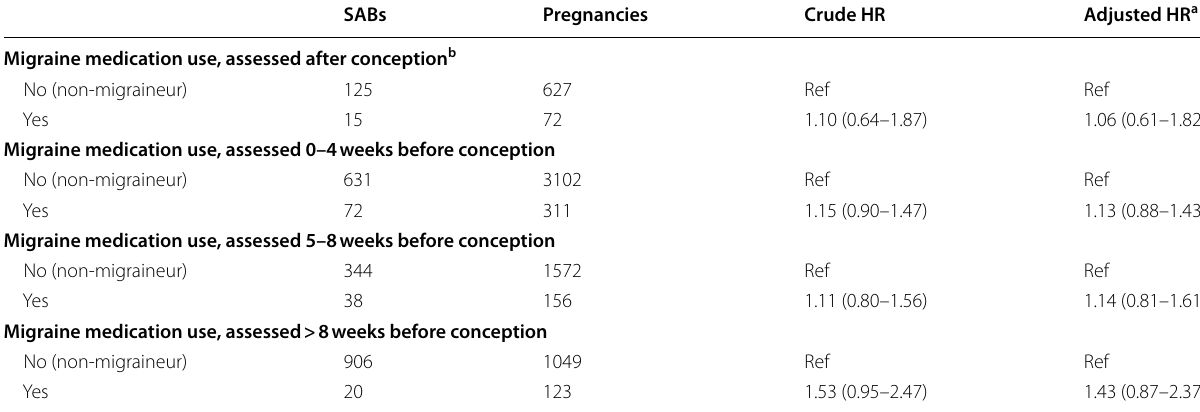
Table 4 Association between preconception migraine medication use and spontaneous abortion, by timing of medication use assessment ( n 7012) . =